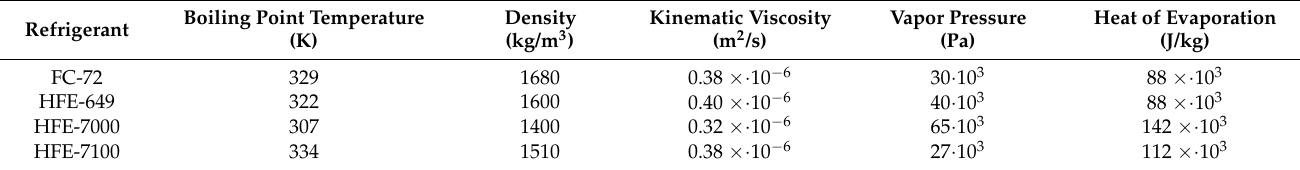
Table 4. Basic physical properties of refrigerants under experimental investigation.